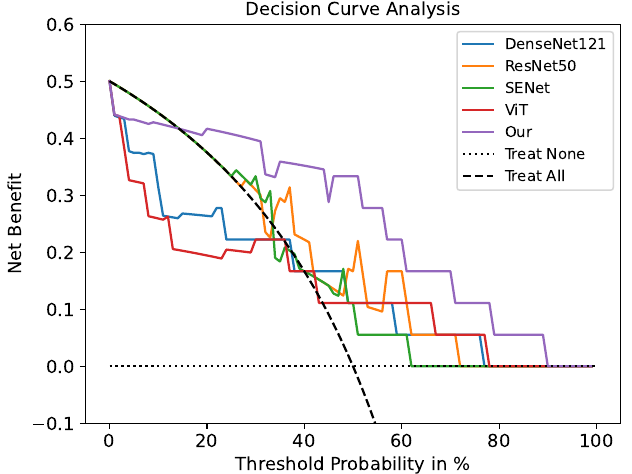
Figure 4. Decision curve analysis for the prediction model using a threshold probability of 0–1. The gray dotted line indicates a situation where no patients are treated. The black dotted line is the condition where everyone is treated. Among the five models, our model has the highest net